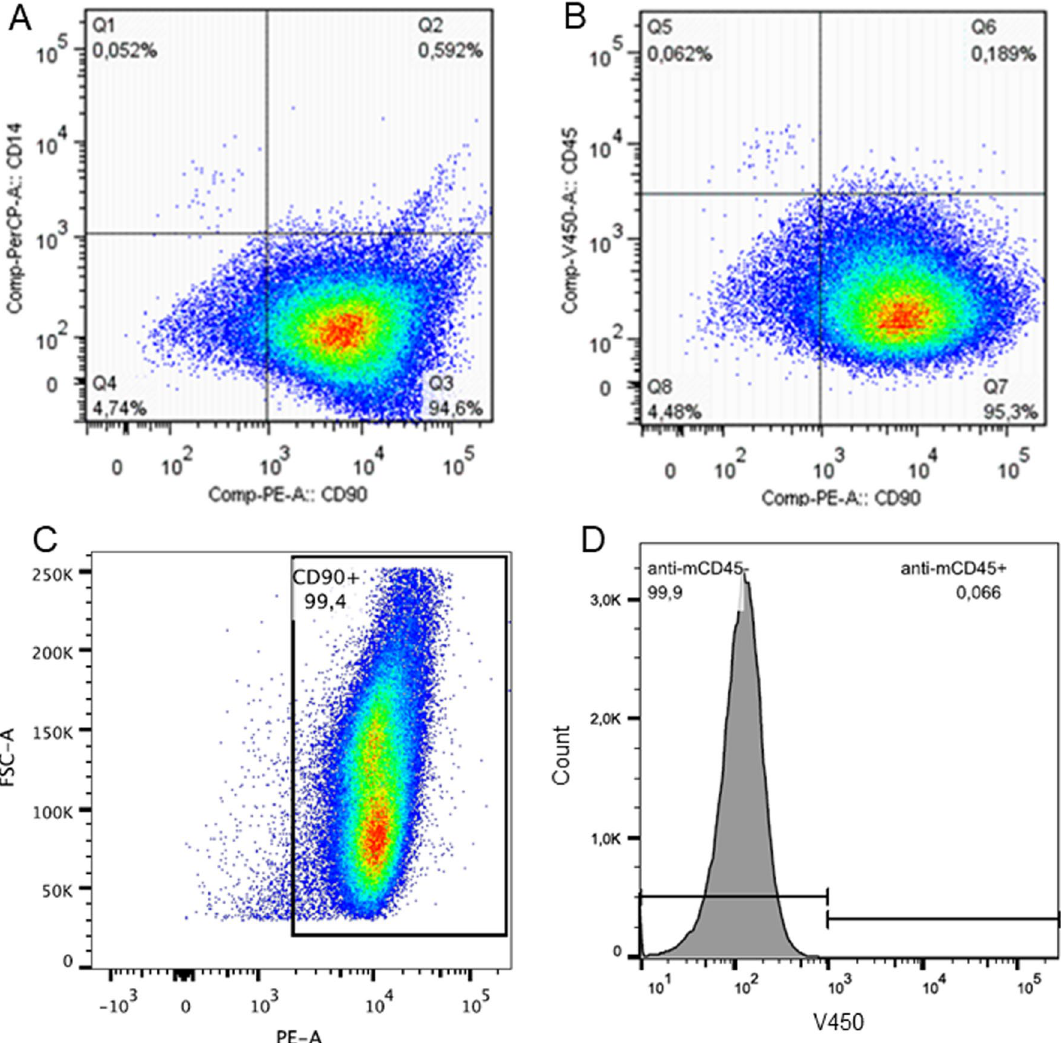
Fig. 1 Immunophenotyping of fibroblast-like synoviocyte cultures from patients with rheumatoid arthritis and mice with collagen-induced arthritis was verified by flow cytometry assays. (A-B) Cell cultures from RA patients were stained with the surface markers CD90, CD14 and CD45. A CD90 CD14 and B CD90 CD45 ; C , D Cell cultures from mice with collagen-induced arthritis were stained with the surface markers CD90 and + − + − CD45. C CD90 and D CD45 +